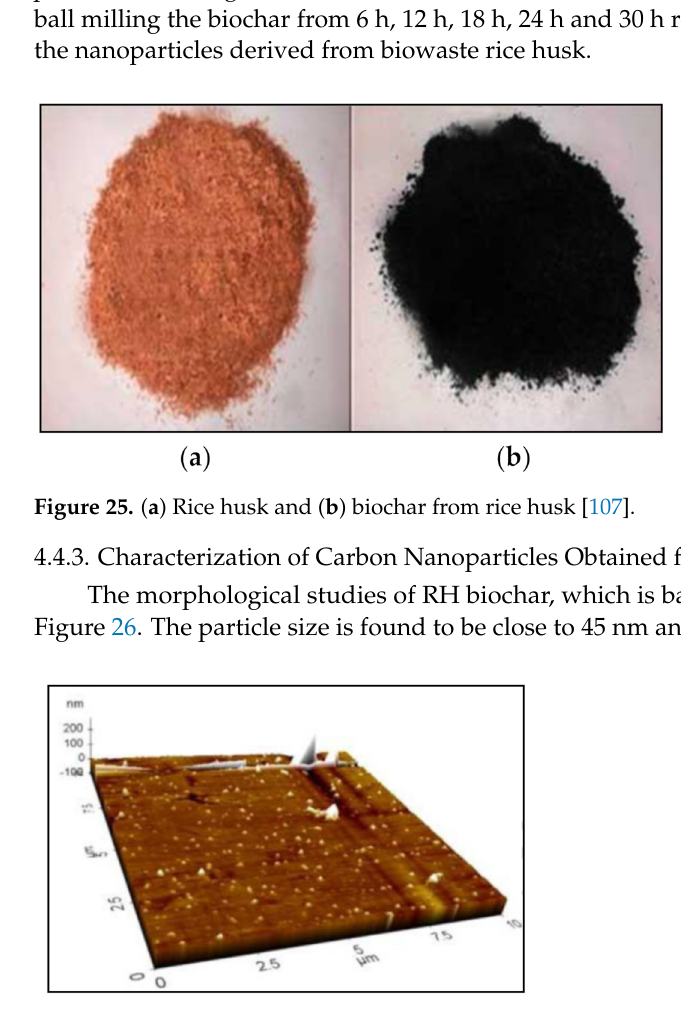
Figure 26. Topography of biochar particles [107].